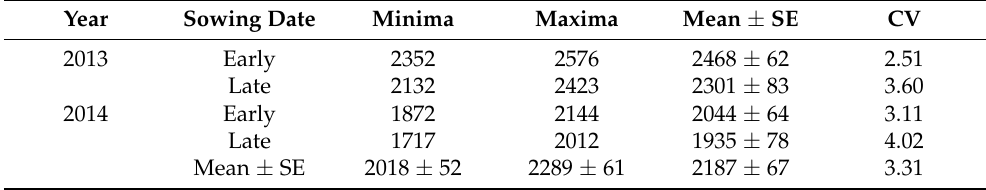
Table 5. Minima, maxima, and mean cumulative growing degree units, cGDUs, during the flowering window for Chadian dry-season sorghum sown early and late at the You é research farms, Chad, in 2013 and 2014. Year Sowing Date Minima Maxima